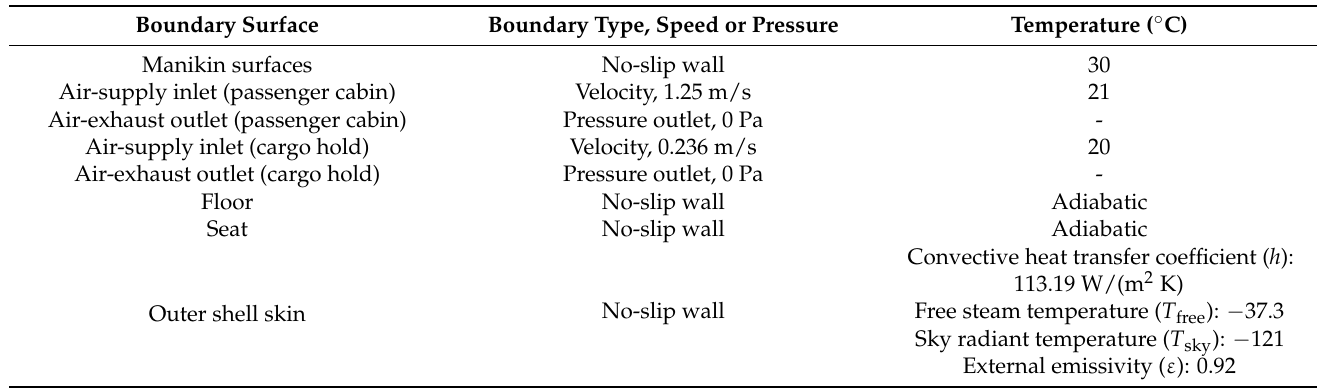
Table 2. Boundary conditions for Case 1